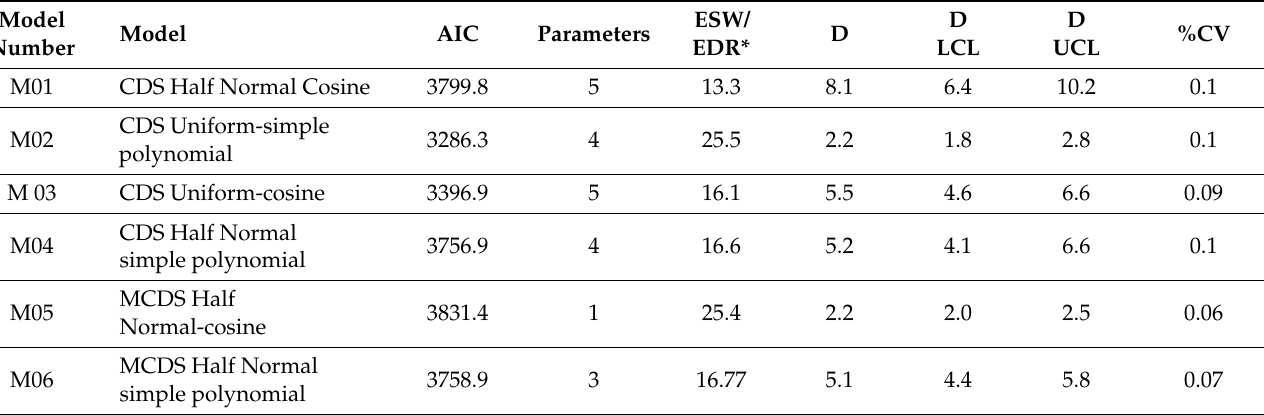
Table 3. Model selection based on estimates of AIC and density (D) for the habitat of the Himalayan Monal in the study area.